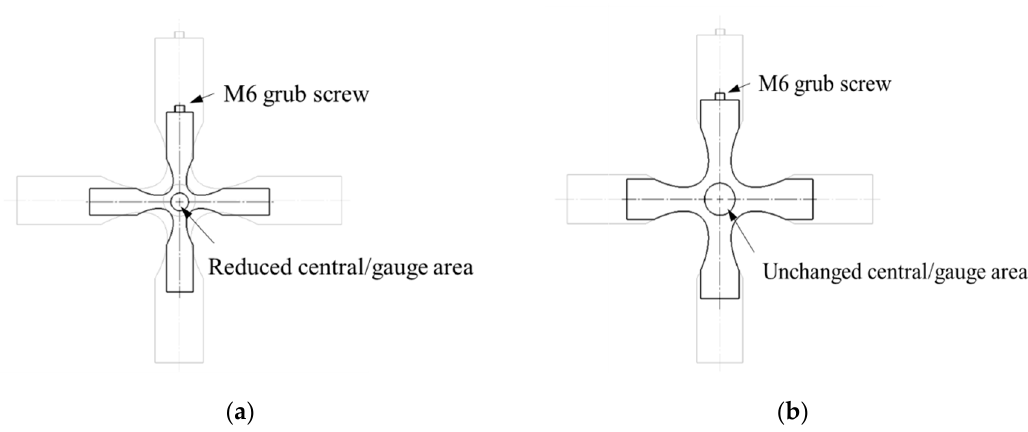
Figure 18. Comparison between the resulting UFT cruciform specimens from the ( a ) “scaling” and from the ( b ) change in arms’ dimensions methods. The original design is faded for comparison purposes. Both UFT designs deliver an in-phase (T-T) mode shape at 20 kHz [26].4.2.3. Tuning for